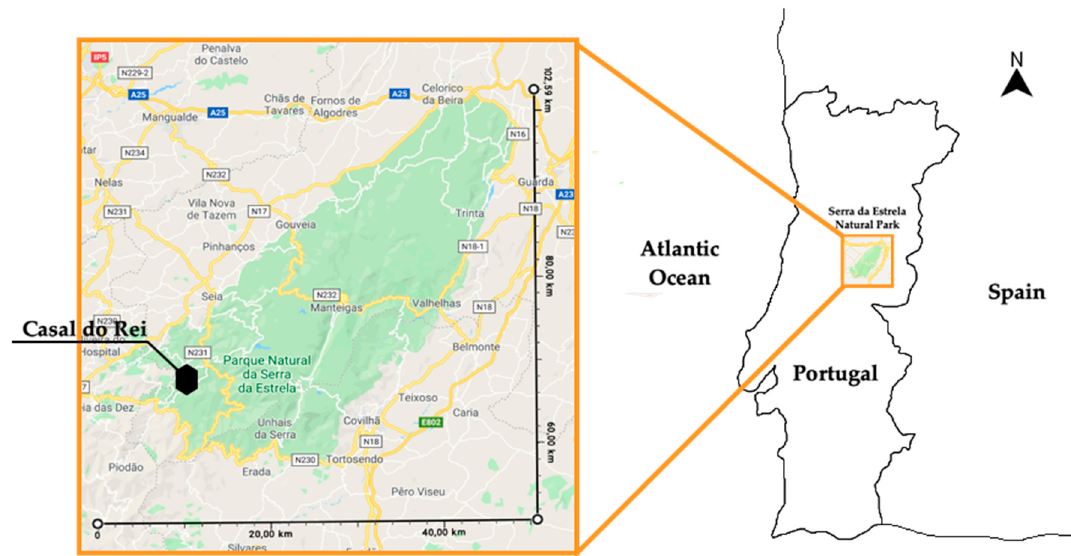
Figure 1. Location of the target area and its regional and national context.